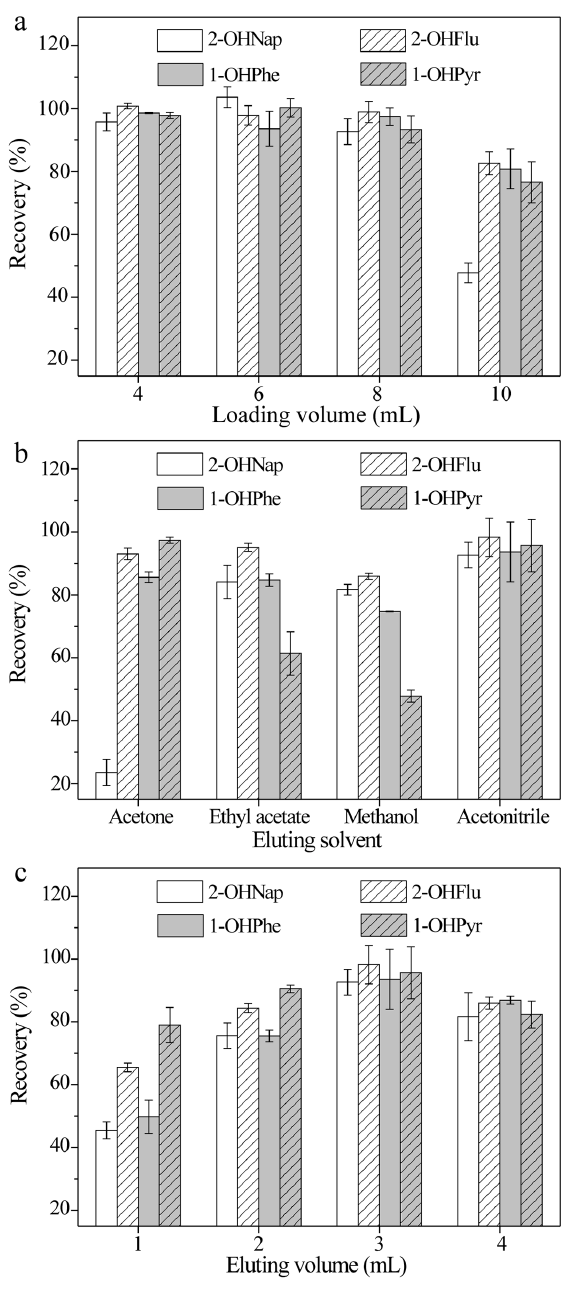
Figure 2. Effect of ( a ) the loading volume, ( b ) the eluting solvent, and ( c ) the eluting volume on the extraction efficiency of four OH-PAHs ( n = 3).